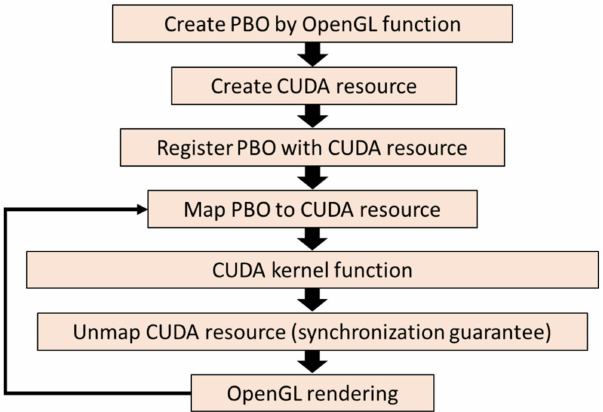
Figure 3. Operational flow of CUDA-OpenGL interoperability.